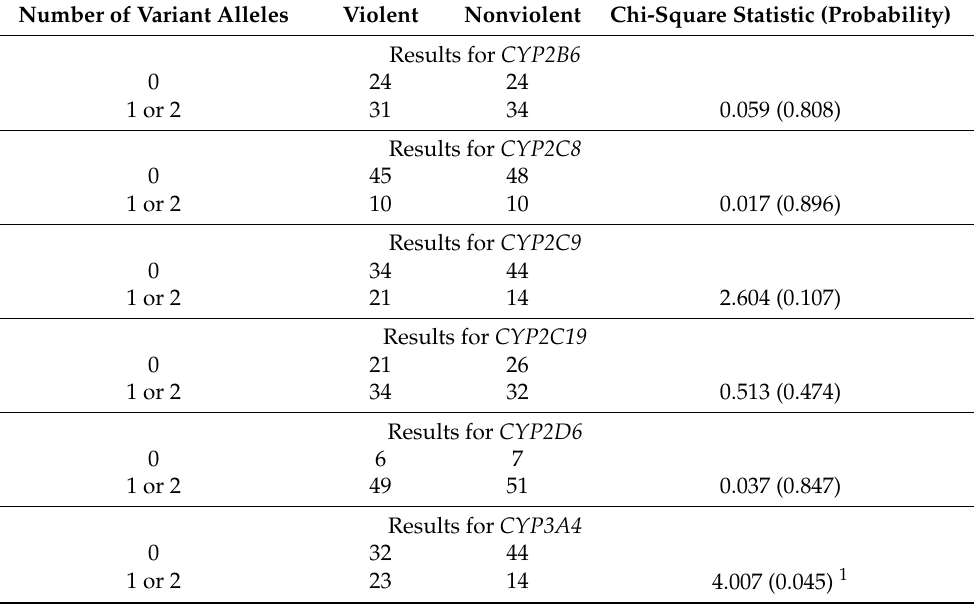
Table 1. Chi-square tests of the distribution of variant alleles on a per gene basis. Number of Variant Alleles Violent